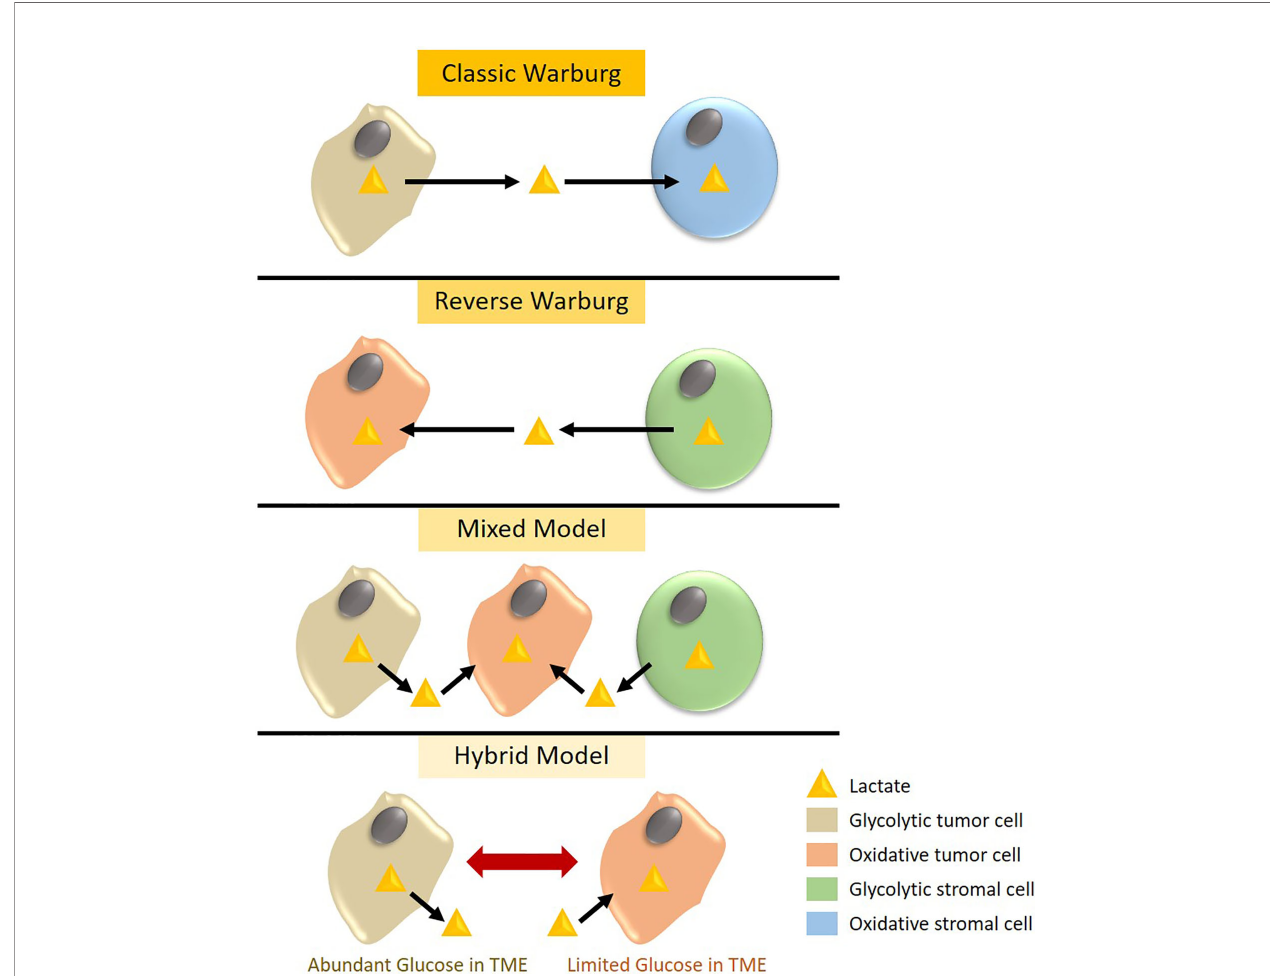
FIGURE 1 | Metabolic phenotypes observed in triple negative breast cancer (TNBC). According to the classic Warburg theory, glycolytic TNBC cells expressing high levels of the lactate transporter MCT4 export lactate, which is taken up by MCT1-expressing stromal cells to generate energy through oxidative phosphorylation (OXPHOS). Alternatively, MCT4 expressing glycolytic stromal cells can export lactate that is used by oxidative tumor cells in a phenomenon called the reverse Warburg effect. The mixed model represents metabolic symbiosis in heterogeneous tumors whereby glycolytic tumor and stromal cells generate lactate to feed oxidative tumor cells. Lastly, the hybrid model depicts metabolic plasticity in TNBC tumor cells that can switch between a glycolytic and oxidative phenotype based on extrinsic cues and glucose availability in the tumor microenvironment